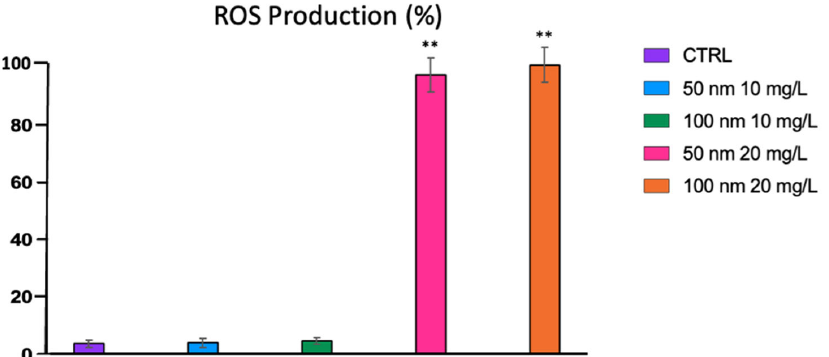
Figure 8. Percentage of organisms exposed to nPS-NH 2 positive for ROS production compared to the control group. Statistical differences ** were observed between control group and organisms exposed to the higher concentration of both nanoplastics ( p < 0.01).